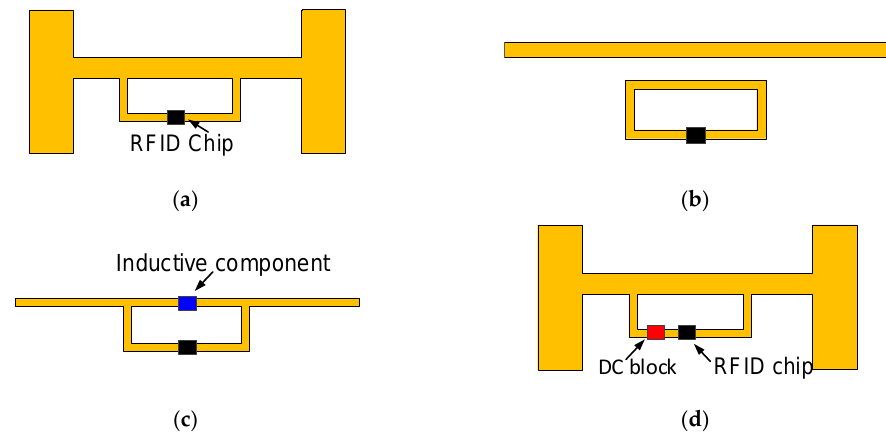
Figure 3. Antenna and chip impedance matching: ( a ) type T; ( b ) parasitic inductive loop; ( c ) inductive passive components; ( d ) DC block.